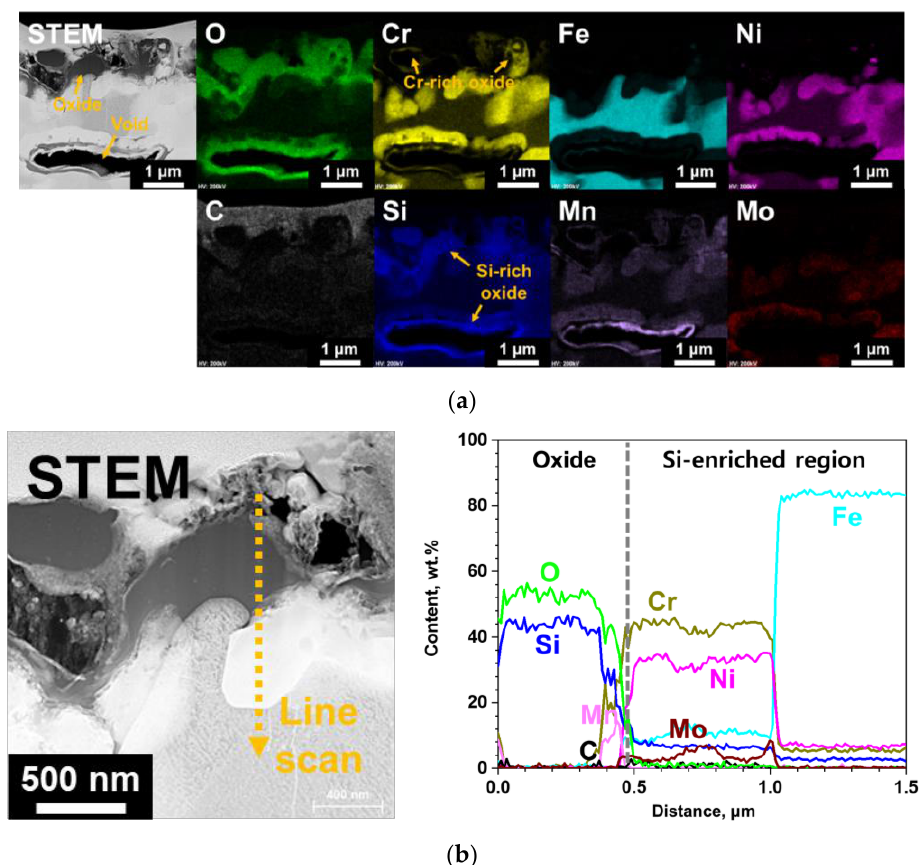
Figure 7. TEM analyses results of the surface-modified SS 316LN after exposure to S-CO 2 at 650 °C (20 MPa) for 500 h. ( a ) Scanning transmission electron microscope (STEM) image with EDS mapping images and ( b ) result of EDS line scan along the dotted line in magnified STEM micrograph on the left-hand side.